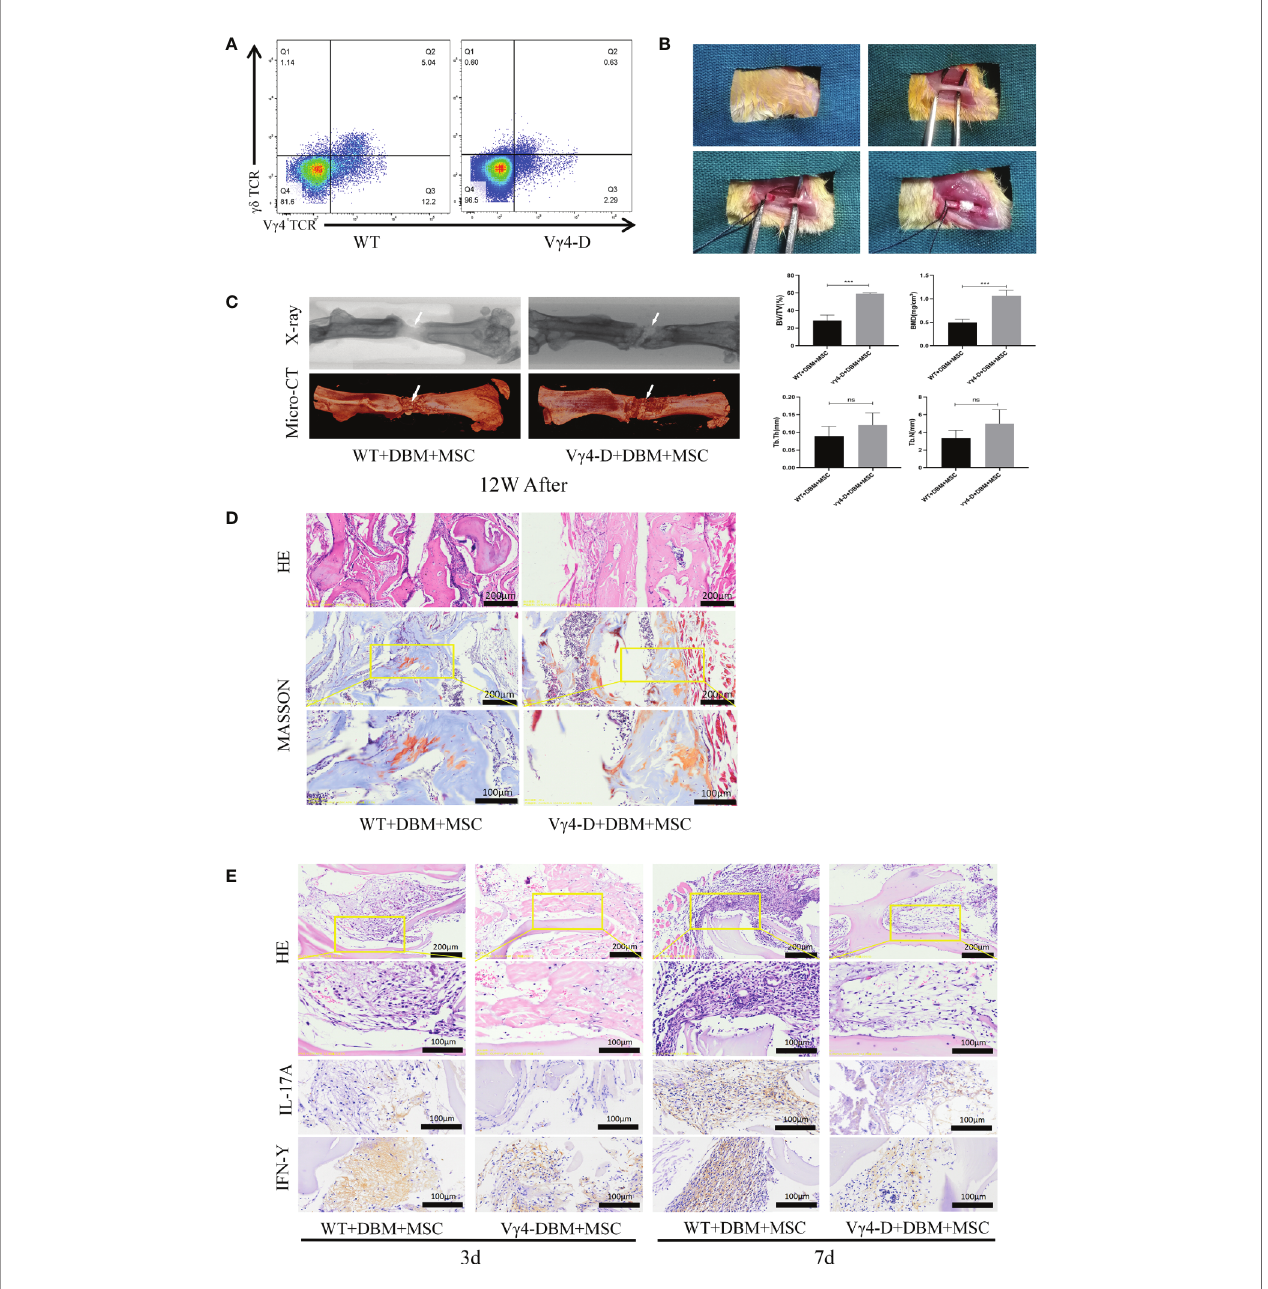
FIGURE 1 | Establishment of femoral nonunion fracture model and Osteogenesis of TEB in vivo of femal Balb/c mice aged 8 weeks old. (A) Constructed V g 4T cells free Balb/c mice (V g 4-D). (B) Process for careting the nonunion fracture models in mice. (C) Morphological analysis of bone formation in 2 groups mice femur defect at 12 weeks after operation and Microarchitecture analyses of bone volume fraction (BV/TV) ,bone mineral density (BMD) , trabecular number of bone formation area (Tb.N) and trabecular thickness (Tb.Th) by X-ray and 3D Reconstruction . Error bars represent mean ± SD. One-way ANOVA test was used to calculated P value (***P < 0.01, ns P > 0.05). (D) Histological analysis of newly formed bone by H&E and Masson ’ s Trichrome staining. (E) In fi ltration of in fl ammatory cells and expressions of IL-17A and IFN- g detected by immunohistochemistry at 3 days and 7 days post